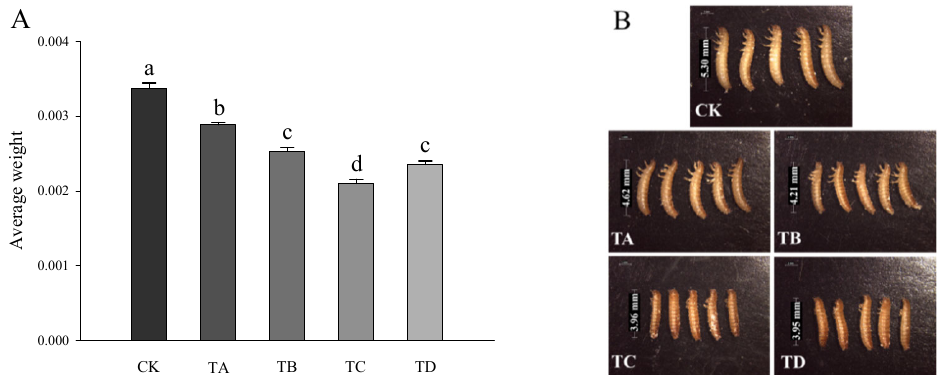
Figure 2. ( A ) Body weight and ( B ) morphological changes in T. castaneum treated with different concentrations of high carbon dioxide. A total of 20 larvae were collected for weighing, and 5 larvae were randomly collected for phenotype photographing. Weighting was repeated three times. A one-way analysis of variance (ANOVA) was performed to test for statistical significance. Dates are presented as the means ± SE; different letters indicate significant differences between values ( p <